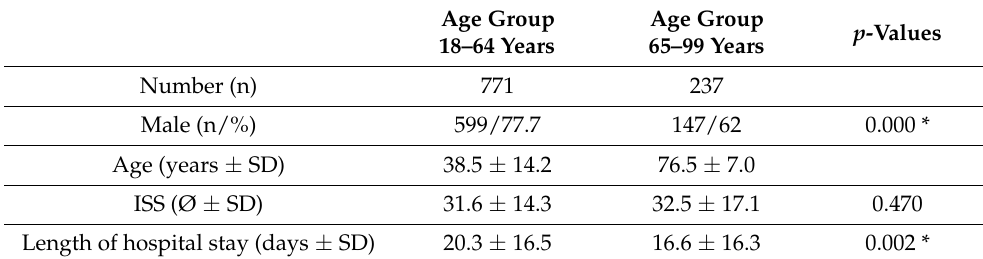
Table 1. Age, gender, ISS, length of hospital stay, injury pattern and trauma mechanisms were recorded. Injury severity was assessed with the AIS (Abbreviated Injury Score) [12]. Groups were compared regarding ISS body regions: head, face, chest, abdominal/pelvis, extremities and external/other. All injuries with an AIS ≥ 1 were included in the evaluation. Table 1. Demographic data of analyzed